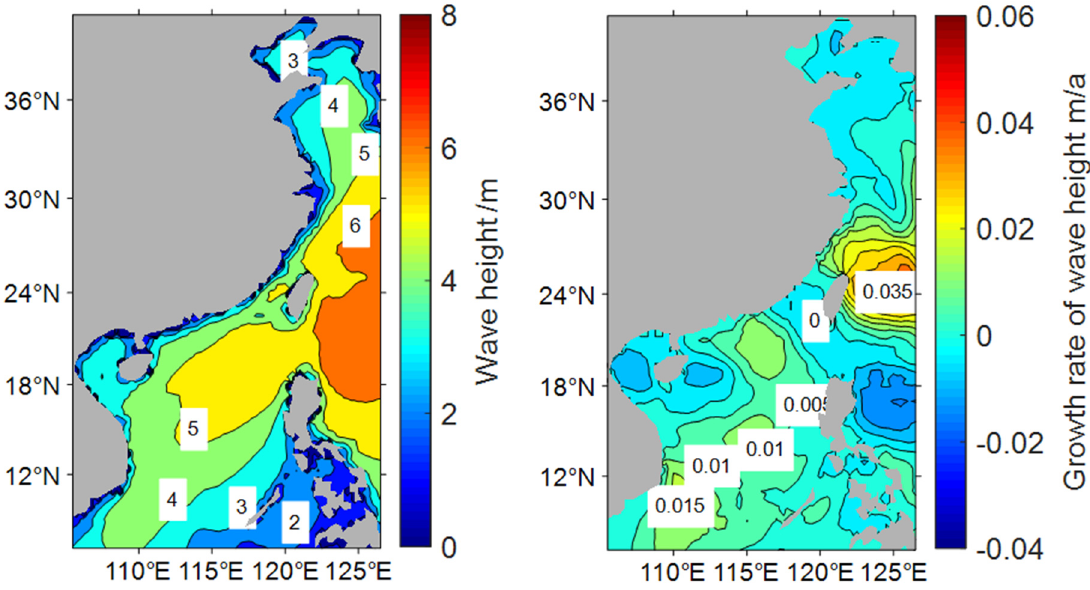
Figure 10. The distribution of annual mean H E at the 99% quintile ( H 99 ) and the annual mean growth rate of H E .